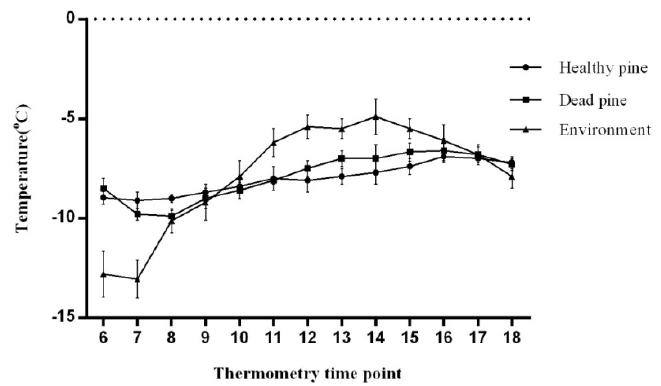
Figure 1. Variation of temperature inside and outside of P. tabuliformis over time.